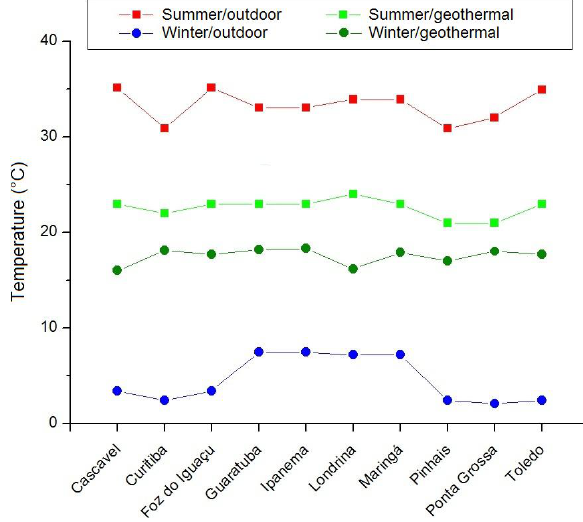
Figure 5: Summary of external and geothermal temperatures, deter- mined in different measuring stations in summer and winter.